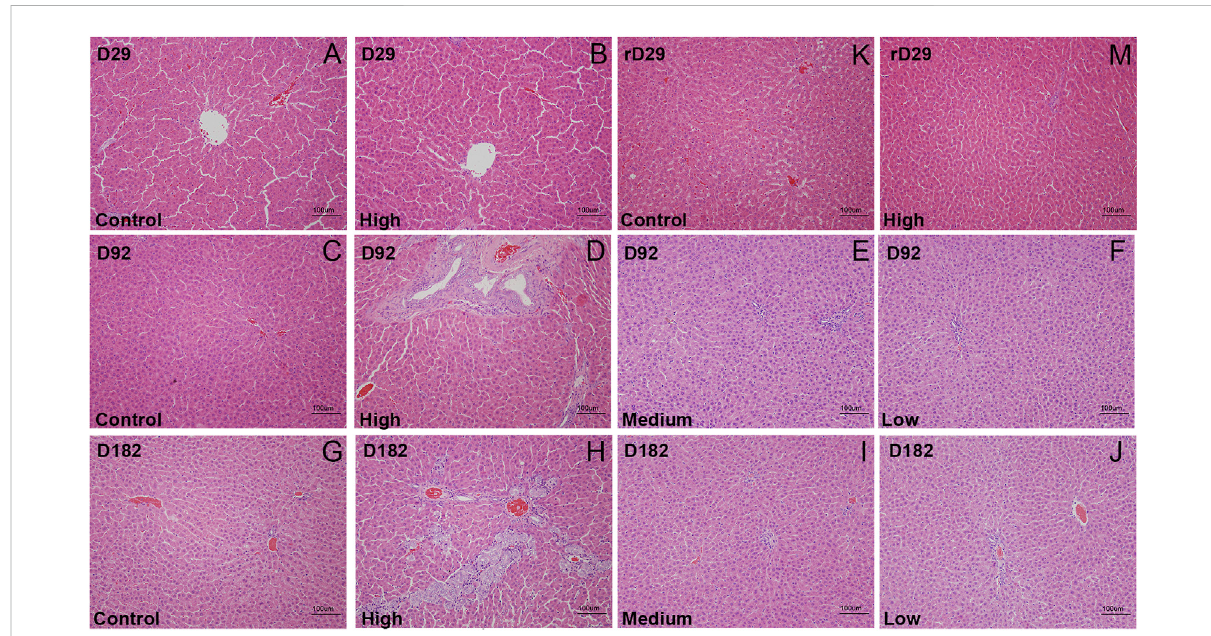
FIGURE 3 The histopathological analysis (H&Estaining × 200) of liverof thecontrol group and high-dose group were performed atD29 (A andB) , D92 (C and D) , D182 (G and H) and rD29 (K and M) , of the midium-dose group and low-dose group were performed at D92 (E and F) and D182 (I and J) , respectively.